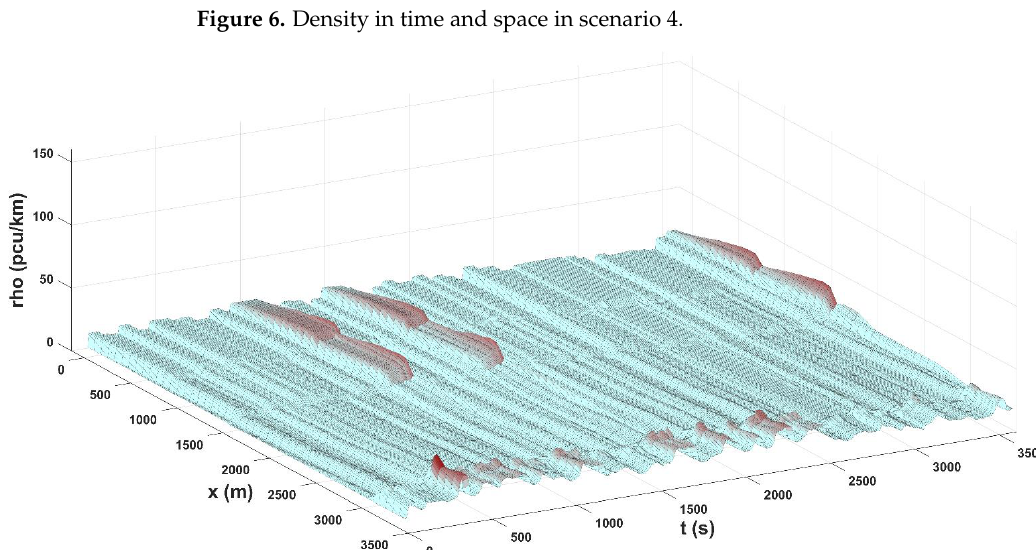
Figure 6. Density in time and space in scenario 4.